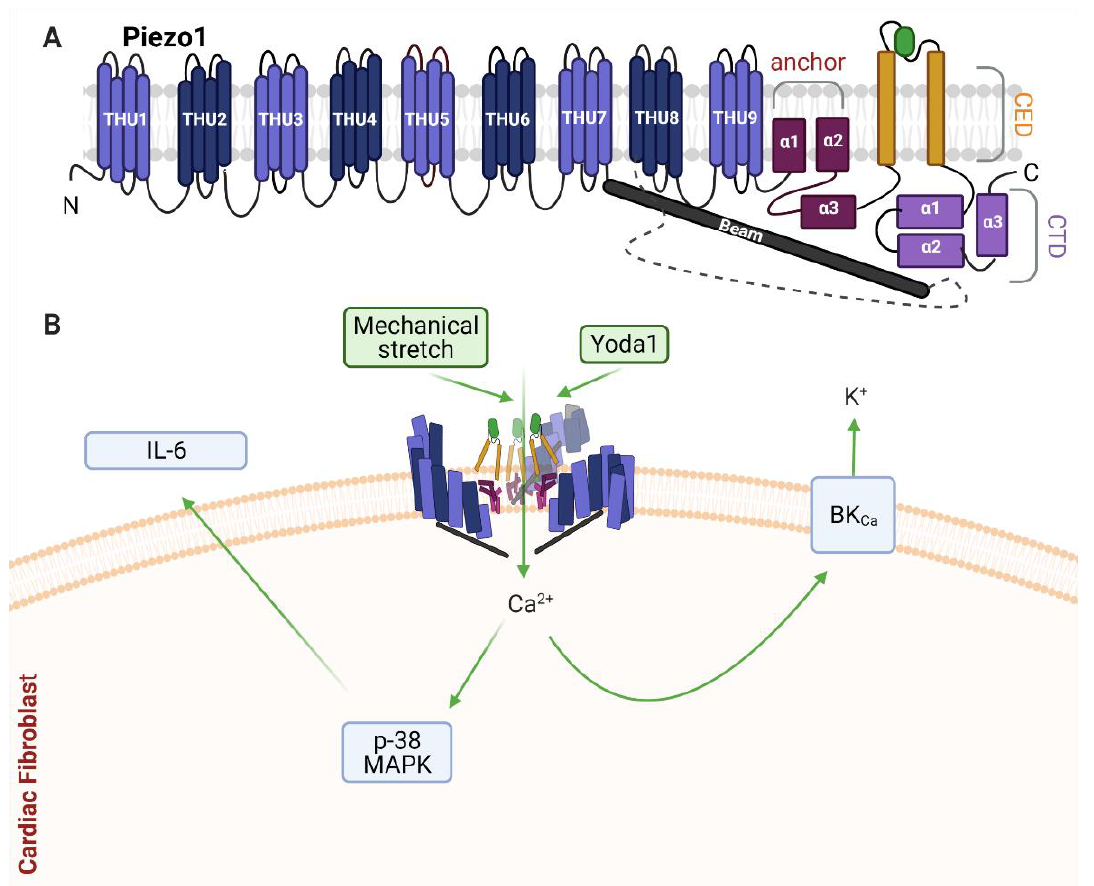
Figure 5. Schematic diagram of Piezo1 structure and cardiac fibroblast signalling. ( A ) Predicted basic alpha subunit structure of mammalian Piezo1. Piezo1 is predicted to have a peripheral transmembrane segment comprised of nine transmembrane helical units (THU1-THU9), an anchor domain ( α 1-3), C-terminal extracellular domain (CED), C-terminal domain (CTD), and a beam-like structure facing the intracellular surface. ( B ) Known Piezo1 homotrimeric ion channel signalling in cardiac fibroblasts. Mechanical stretch and Yoda1 both activate Piezo1 in cardiac fibroblasts. Mechanical stimulation of Piezo1 activates the potassium-selective Ca 2+ -activated channel of large conductance (BK Ca ). Yoda1 activation of Piezo1 activates the p38 α MAPK pathway and stimulates IL-6 gene expression and protein secretion. See main text for details.